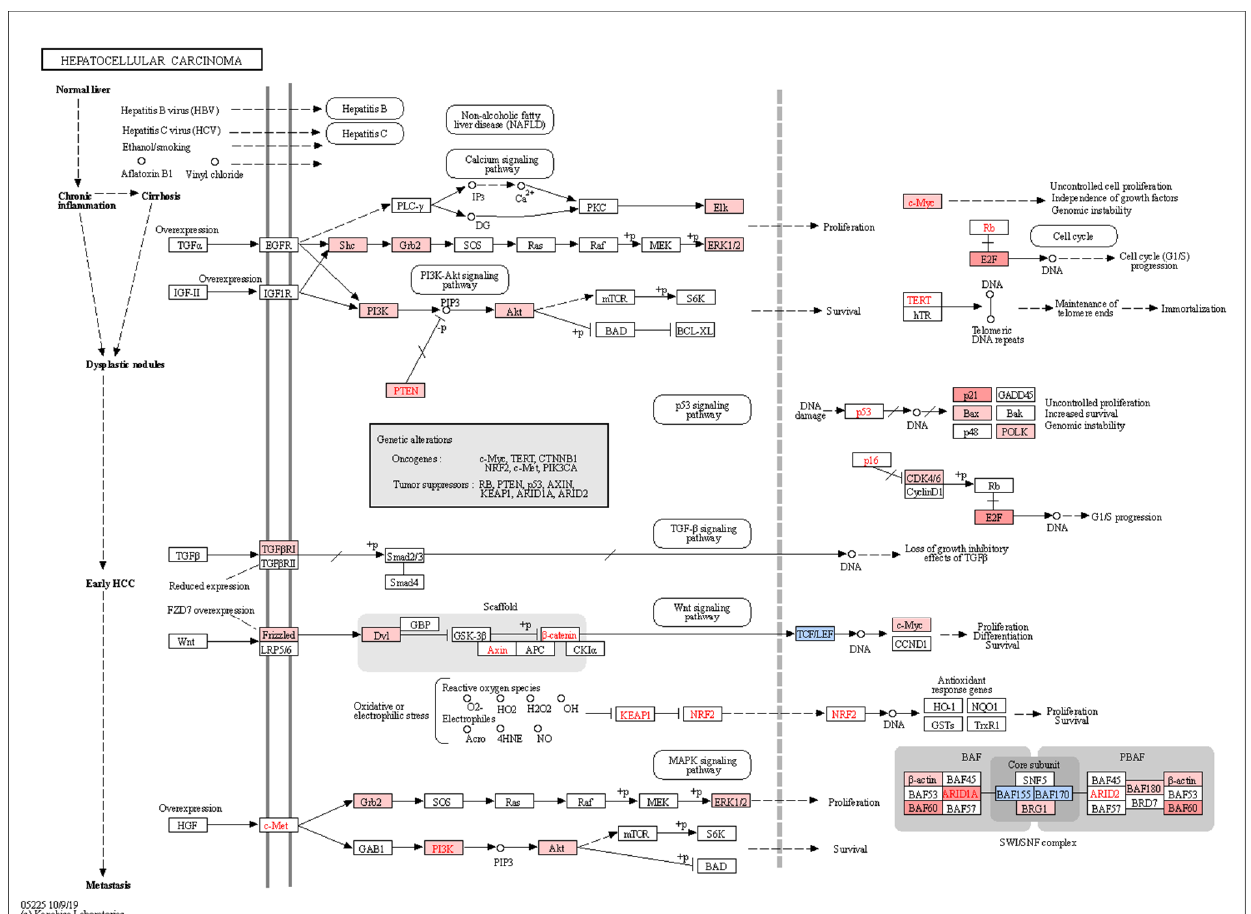
Figure 7. Pathways contributing to the development of hepatocellular carcinoma are differentially induced by miRNA dysregulation in HCC donors. Genes regulated by miRNAs positively or negatively enriched in HCC compared to non-HCC donors are matched to KEGG hepatocellular carcinoma pathway. Genes in blue correspond to those modulated by miRNAs associated with HCC as shown in Figure 5A, and thus, differentially downregulated in HCC donors. Conversely, genes in red are regulated by miRNAs negatively associated with HCC (Figure 5B) and thus, are differentially upregulated in HCC donors due to loss of miRNA regulation in this subset of donors.